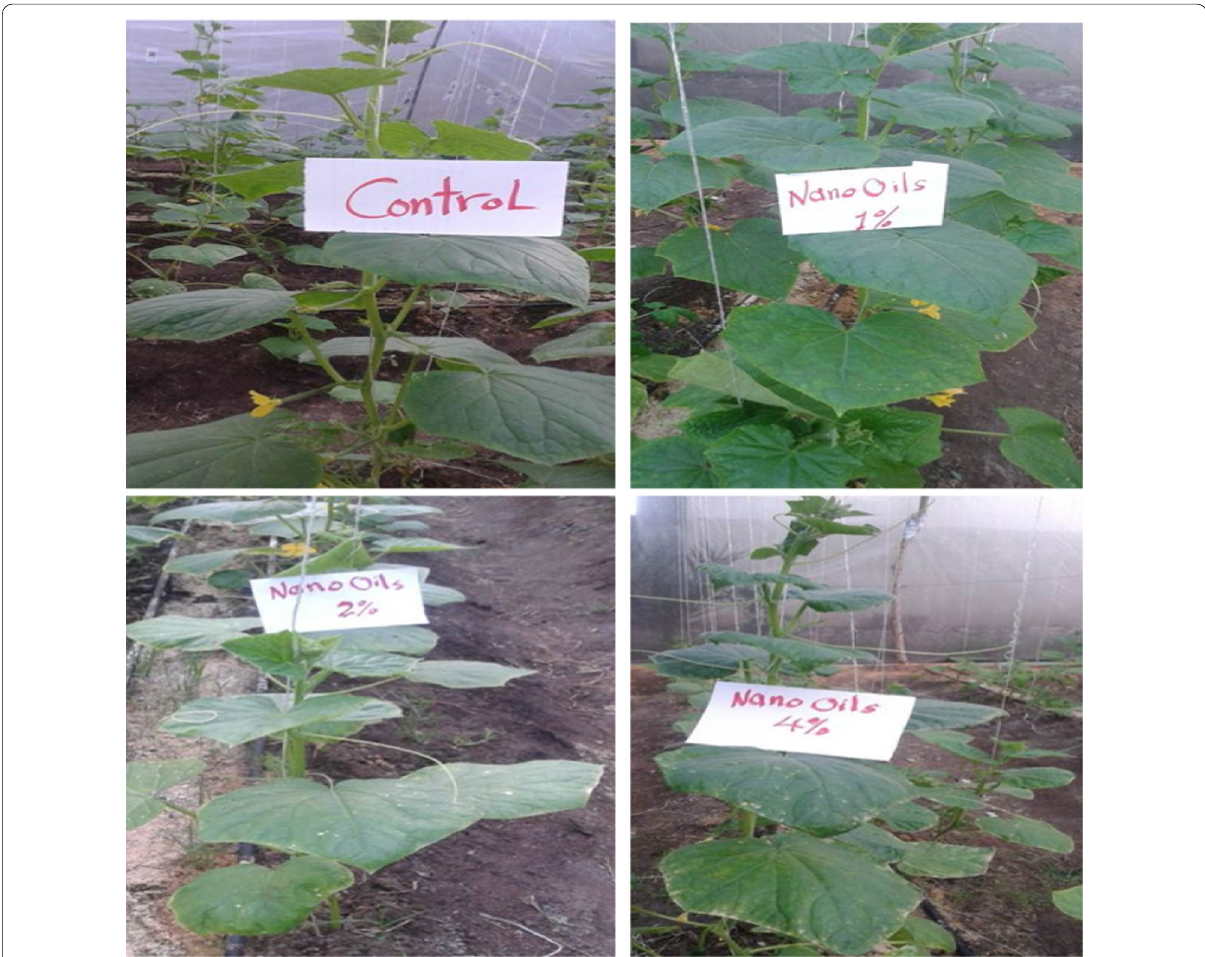
Fig. 4 Phytotoxicity test of nanoemulsion formulation of clove cucumber plants